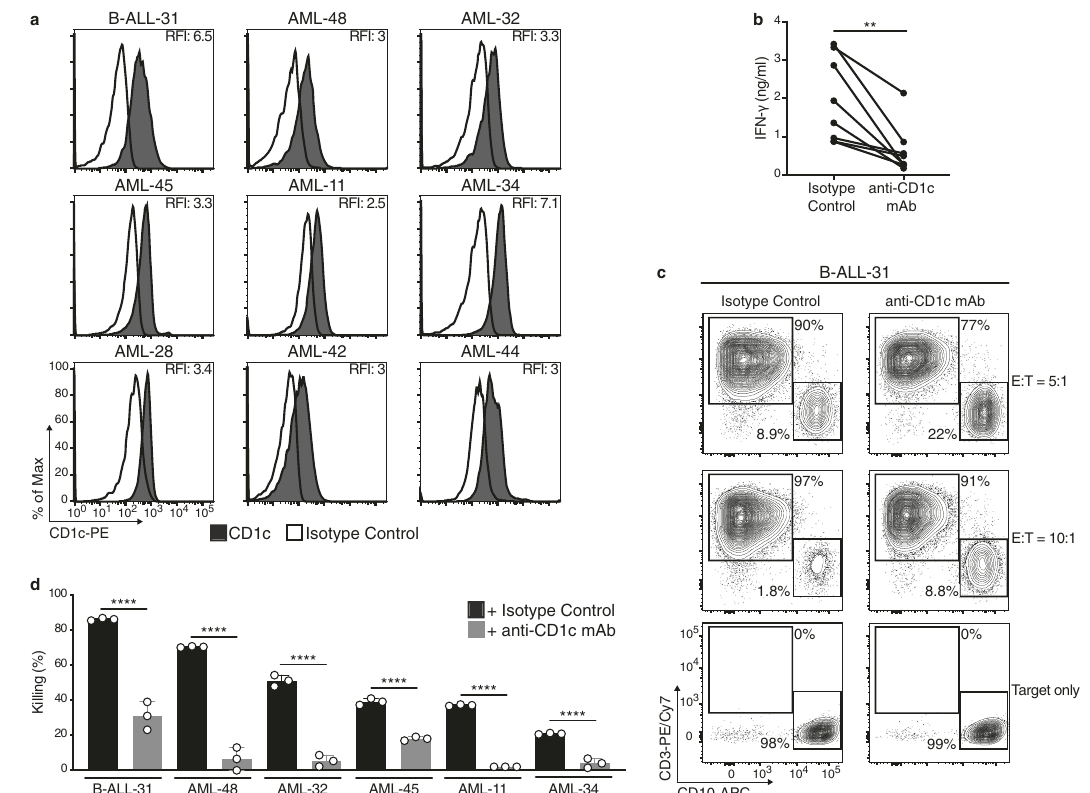
Fig. 5 DN4.99 TCR-T cells ef fi ciently recognize and kill primary CD1c + Acute Leukemia Blasts in vitro. Primary T cells were transduced with DN4.99 TCR (DN4.99 TCR-T cells), separated by cell sorting into CD4 + and CD8 + T cells, and mixed back again to generate a mixture of 70-80% CD8 + and 30- 20% CD4 + cells, which was assessed in vitro for the recognition and killing of CD1c-expressing primary circulating acute leukemia blasts. a Flow cytometry detection of CD1c expression (black histograms) on ex vivo B-Acute Lymphoblastic Leukemia (B-ALL) and Acute Myeloid Leukemia (AML) blasts labeled with anti-human CD1c monoclonal antibody (mAb). White histograms represent labeling with isotype-matched control mAb. Relative Fluorescence Intensity (RFI) was calculated as the ratio between the intensity of labeling of sample and control. b Recognition of primary CD1c + AML blasts by CD8 + /CD4 + DN4.99 TCR-T cells, co-cultured for 48 h at 10:1 or 5:1 Effector:Target (E:T) ratio with either 20 μ g/ml of blocking anti-CD1c mAb or an equivalent concentration of mouse IgG1 κ isotype control. IFN- γ secretion into supernatants was measured by ELISA. c Representative killing of the target leukemia B-ALL-11 blasts by CD8 + /CD4 + DN4.99 TCR-T cells, determined by fl ow cytometry labeling after 48 h of the same co-cultures. d Killing of each indicated primary blast by CD8 + /CD4 + DN4.99 TCR-T cells of the same co-culture conditions of ( b ), expressed as % of killing, as described in Methods. Gray bars represent co-cultures with anti-CD1c mAb, and black bars with the isotype control. Allogenic CD8 + /CD4 + DN4.99 TCR-T cells were from 3 independent healthy donors. Data are represented as mean ± SD. ** P = 0.003 determined by unpaired two-tailed t-test followed by Mann – Whitney test ( b ). **** P < 0.0001 determined by Ordinary one-way ANOVA followed by Tukey ’ s multiple comparison test ( d